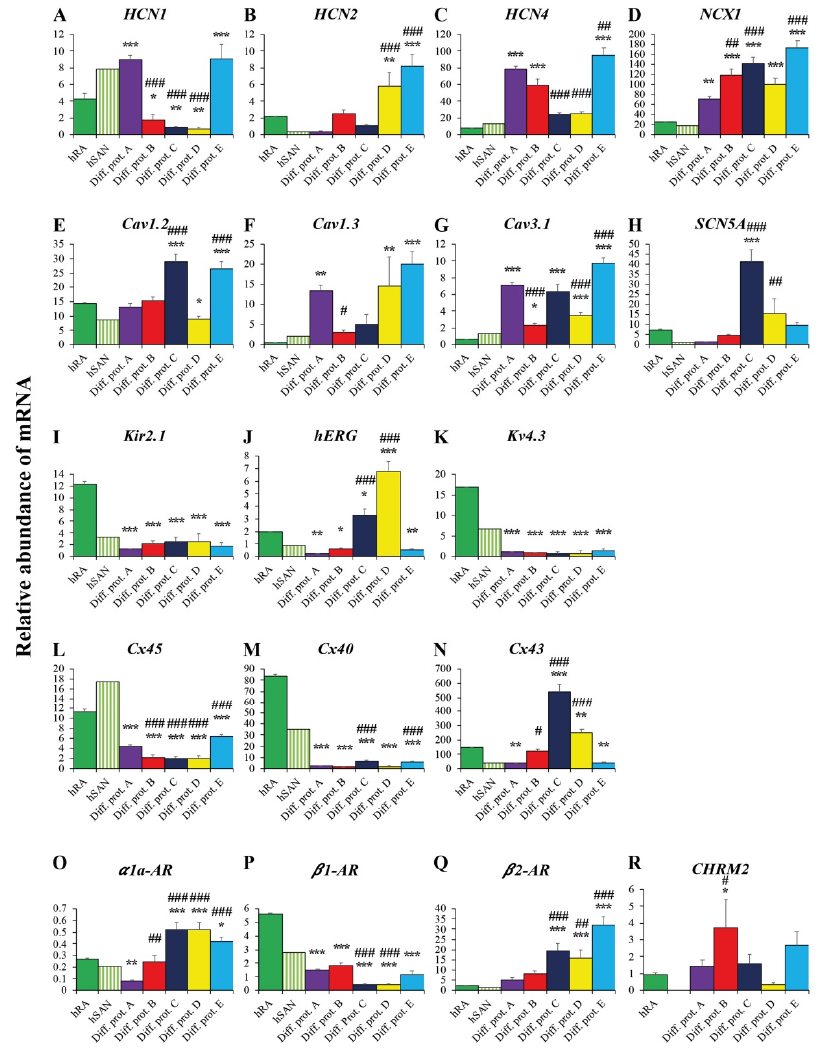
Figure 4. Gene expression of ion channels, transporters, connexins, adrenergic and cholinergic receptors in cardiac pacemaker cells. Abundance of mRNA transcripts (in%) relative to gene expression of the housekeeping genes GAPDH/HPRT1/ACTB . ( A – C ): HCN channels. ( D ): Na-Ca exchanger NCX1